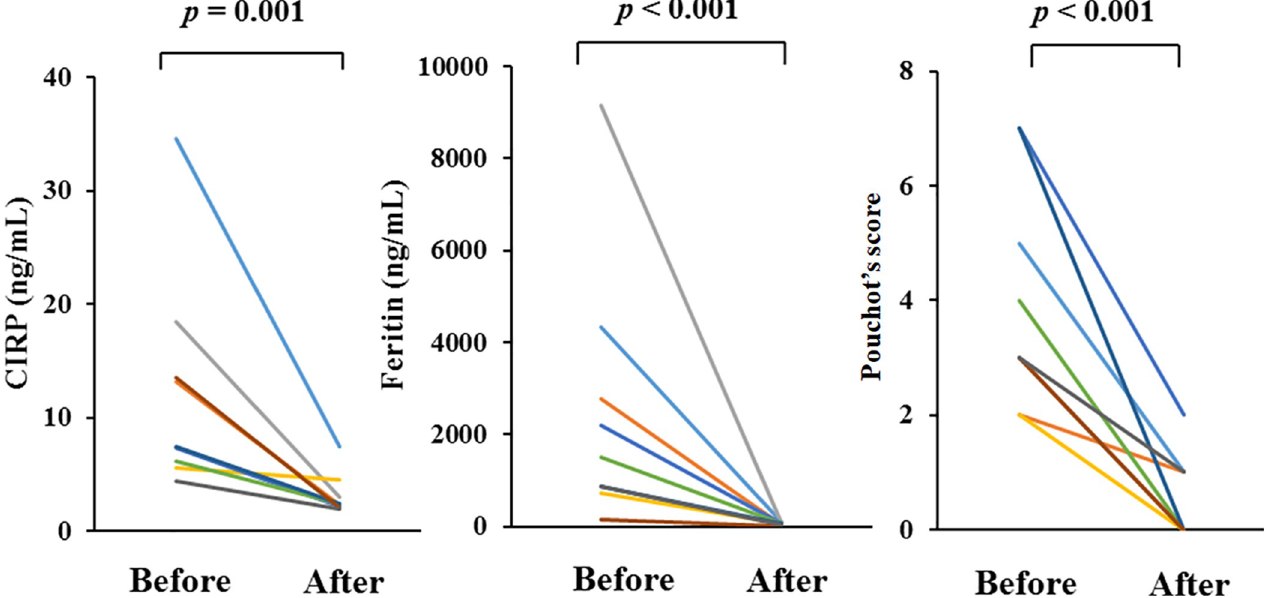
Fig 5. Longitudinal changes of serum levels of CIRP (A), ferritin (B) and disease activity score (Pouchot’s score) in 8 patients with active AOSD before and after immunosuppressive treatments. Paired samples from the same subjects (n = 8) were compared by Wilcoxon signed-rank test.